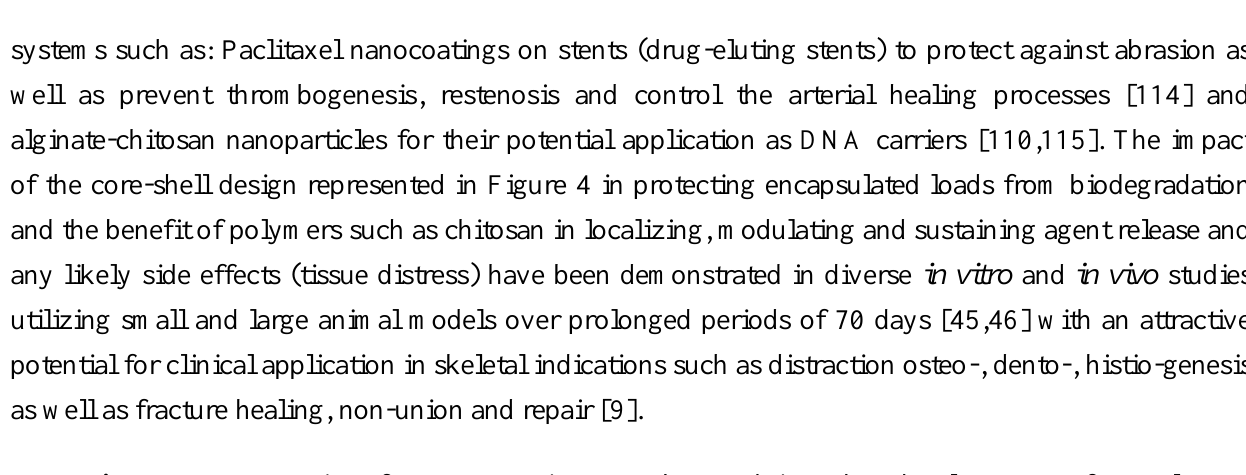
Figure 4. Synopsis of some previous works studying the development of novel L-b-L self-assembled Core-Shell Hybrid